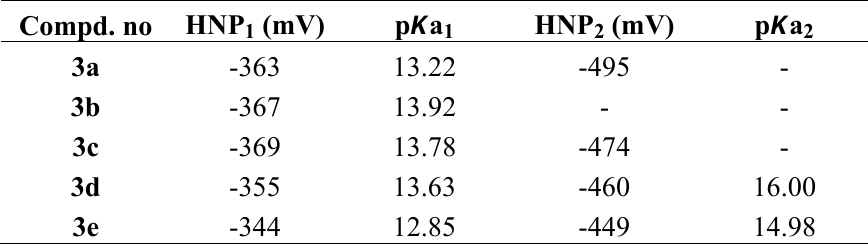
Table 1. The half-neutralization potentials (HNP) and the corresponding p K compounds 3a-3e in isopropyl alcohol at 25